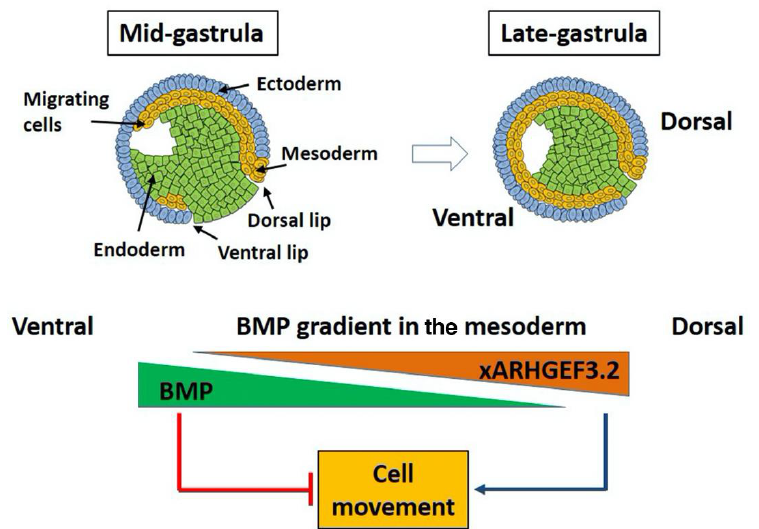
Figure 8. Proposed model of the Bmp-Arhgef3.2 gradient in the modulation of cell movement in the gastrula Xenopus embryos. In the proposed model, Bmp gradient inversely modulates expression of Xarhgef3.2 , which in turn regulates cell movement in gastrula embryos, leading to active gastrulation movement in the dorsal region and a weak gastrulation movement in the ventral region of the embryos.